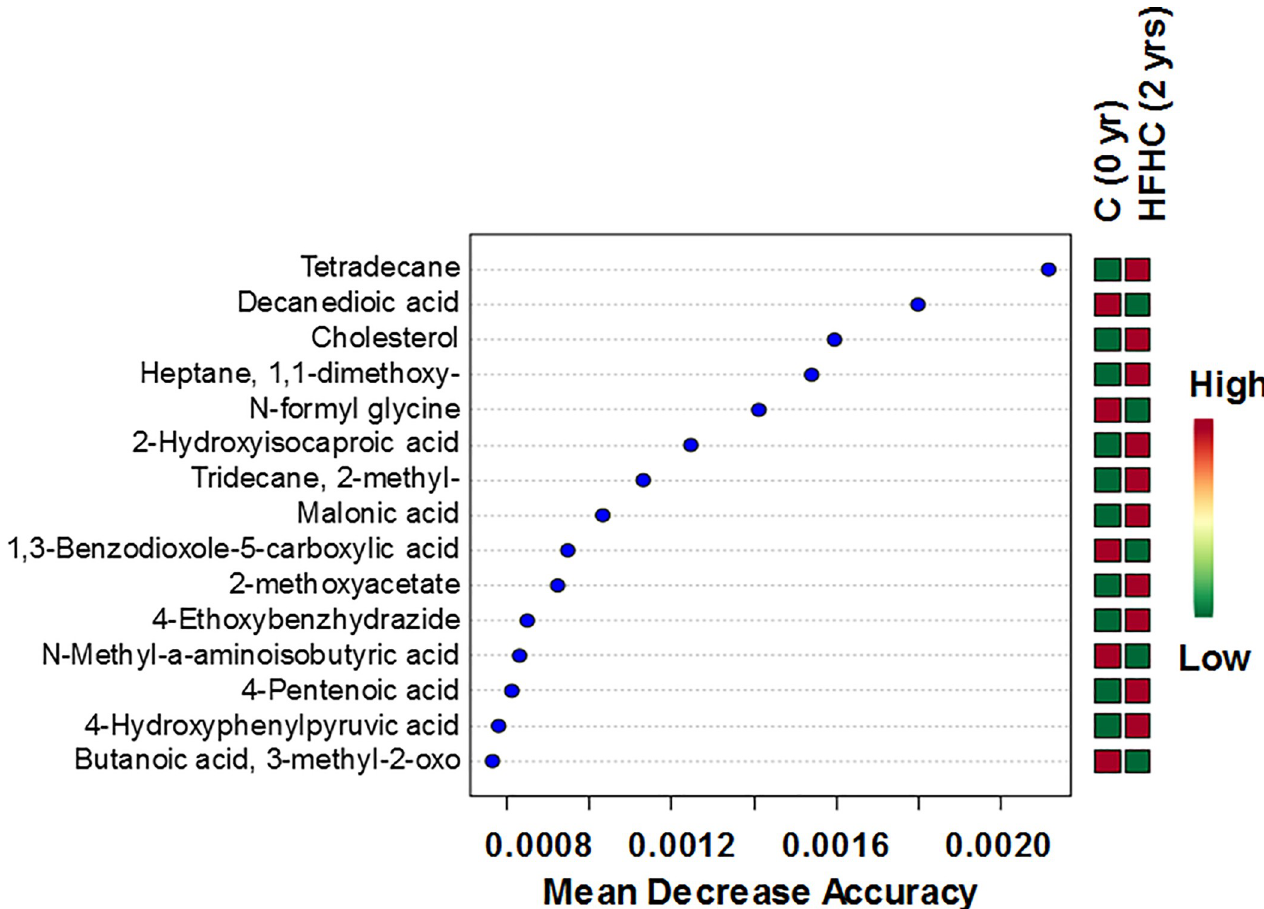
Fig 2. Random forest analysis showing discriminating biomarkers of diet-challenge in their decreasing orders of mean decrease accuracies (MDA). Smaller MDAs tend to be better discriminatory markers than the higher values.